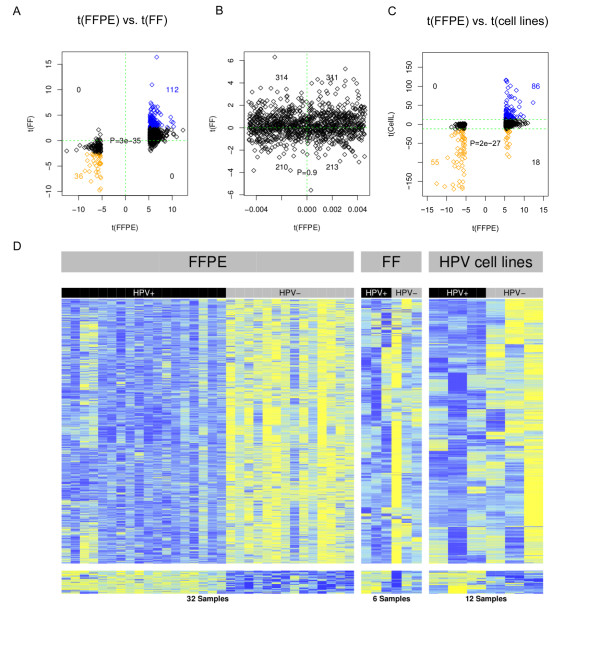
Validation of human papillomavirus-positive (HPV+) and HPV-negative (HPV-) methylation signature. (A-C) Validation of consistency of t-statistics between formalin-fixed, paraffin wax-embedded (FFPE) and (A) fresh-frozen (FF) samples, (B) FF control probes and (C) HPV+ against HPV- cell lines. (D) Heatmap representation of signature of consistent hypermethylated methylation variable positions (hyper-MVPs; top) and hypomethylated MVPs (hypo-MVPs; bottom) in the Infinium DNA-methylation data. The DNA-methylation (β) values are represented using a color scale from yellow (low DNA methylation) to blue (high DNA methylation) normalized across each MVP. The HPV+ head and neck squamous cell cancer (HNSCC) methylation signature contains 2,194 consistent hyper-MVPs and 74 consistent hypo-MVPs across all three datasets. The six HNSCC cell-line samples were run in duplicate.